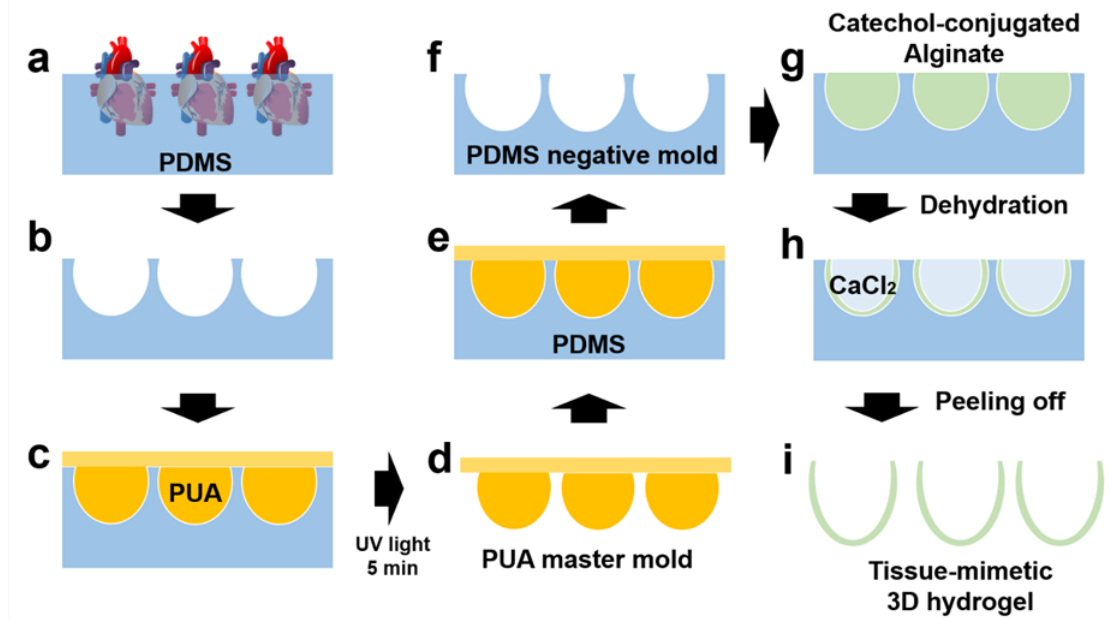
Scheme 1. Schematic illustration of the fabrication procedure of 3D hydrogel film using the catechol-conjugated alginate (ALG-C) hydrogel.